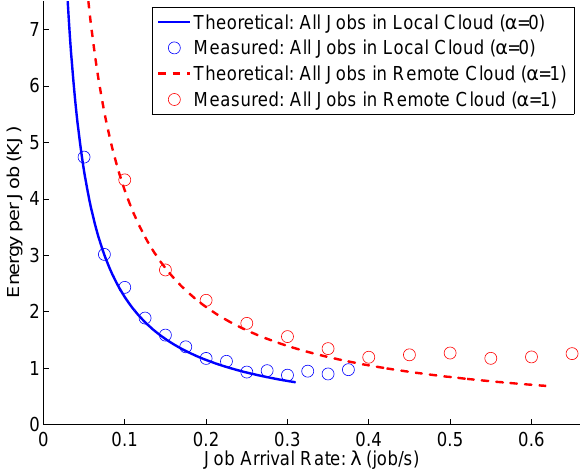
Figure 5. Experimental and theoretical values for the energy per